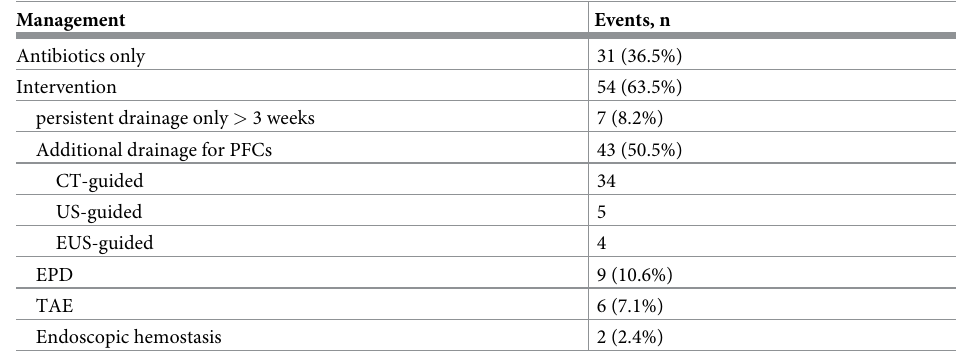
Table 2. Management of grade B postoperative pancreatic fistula after distal